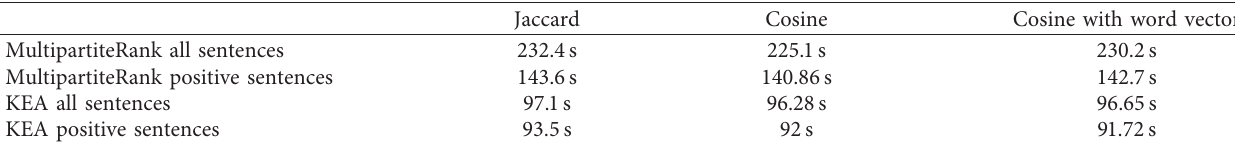
Figure 4: Similarity scores of different supervised and unsupervised keyword extraction techniques for Jaccard, cosine, and cosine with Word vector similarity indexes. Table 4: Runtime comparison in seconds (s) of positive and all sentences’ texts for MultipartiteRank and KEA keyword extraction al- gorithms in terms of Jaccard, cosine, and cosine with Word vector similarity indexes.